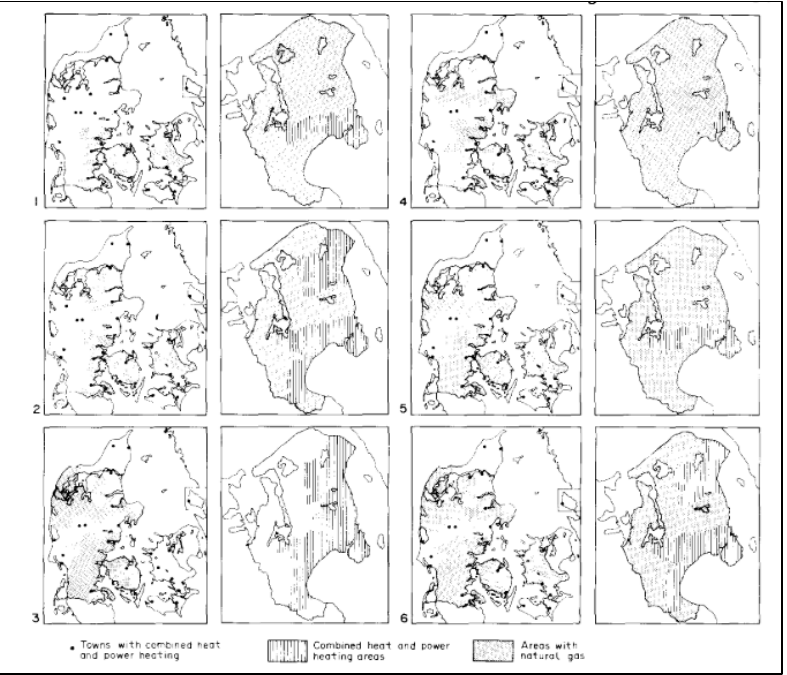
Figure 7. Proposals for regionalization/zoning of heat supply by type of heat supply system. Source: [25]. Notes: The process of zoning comprised three independent stages: (1) Individual municipalities mapped their heat demands, heat supply sources, fuel usage, and assessed future changes in heat demand/heat supplies. The municipalities then sent this information to the regional authorities. The regional authorities were responsible for producing a regional-scale overview of the heat supplies. Based on this regional overview, (2) the municipalities created preliminary plans for their